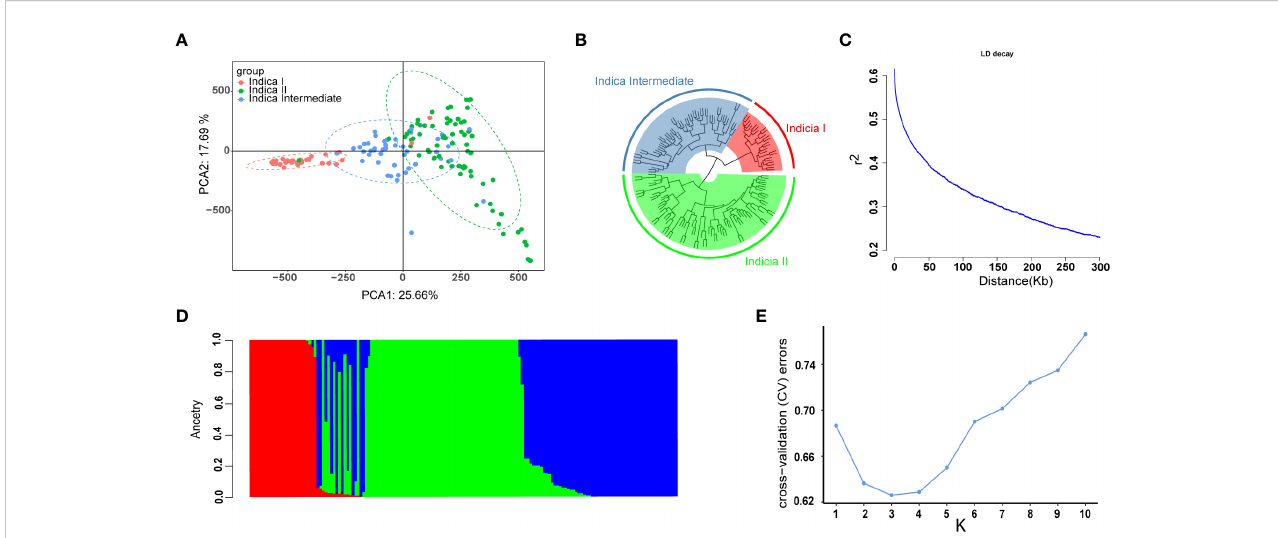
FIGURE 2 Population structure and LD decay of 159 rice accessions. (A) Principal component analysis (PCA) of the association panel. (B) Cluster analysis results of 159 rice accessions with 2,017,495 SNPs. (C) The entire genome LD decay of the population. (D) Population structure estimates (K = 3), the areas of the three colors illustrate the proportion of each subgroup. (E) cross-validation (CV) error line graph of subgroups (K =